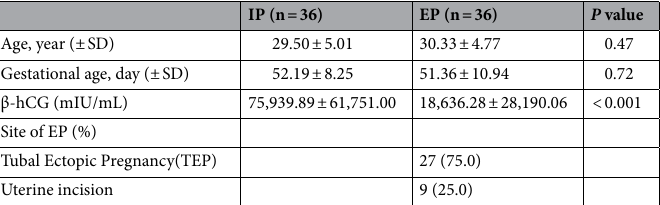
Table 1. Baseline of the study population. IP intrauterine pregnancy, EP ectopic pregnancy, SD standard deviation, hCG human chorionic gonadotropin.